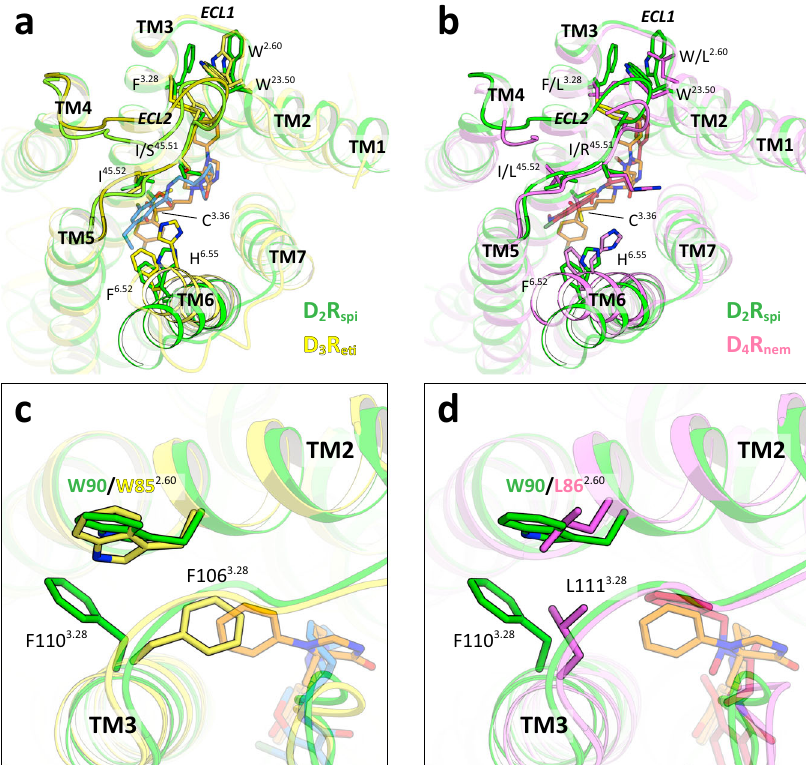
Fig. 5 Comparison of D 2 R spi , D 3 R eti and D 4 R nem . Extracellular view of the superpositions of D 2 R spi and either D 3 R eti ( a ) or D 4 R nem ( b ). c The EBP of D 2 R spi and the corresponding part of